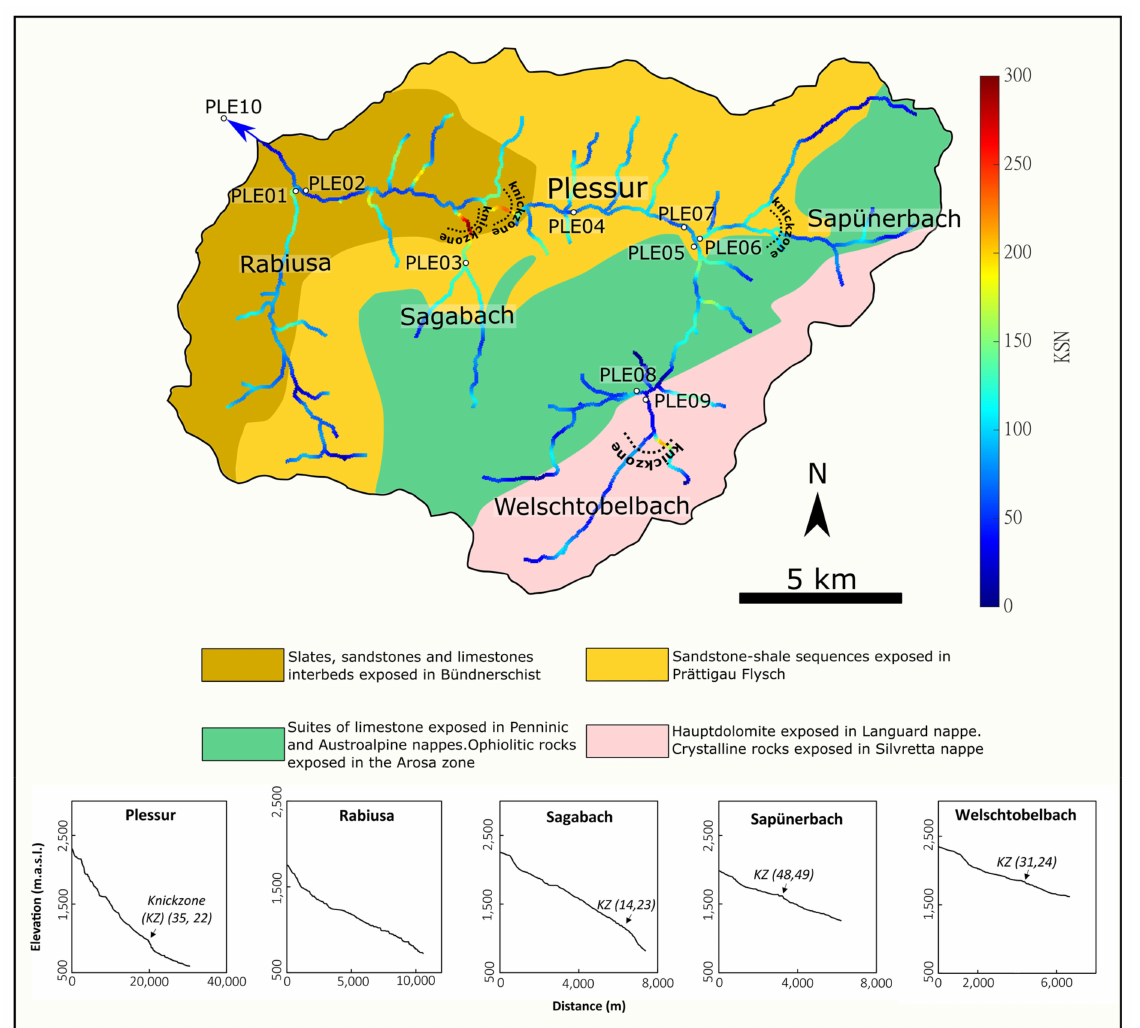
Figure 6. Map of normalized steepness indices (k sn ) displayed in a simplified lithotectonic framework for the Plessur Basin. The knickzones are identified in the map and in the stream profiles (see also Figure 5).